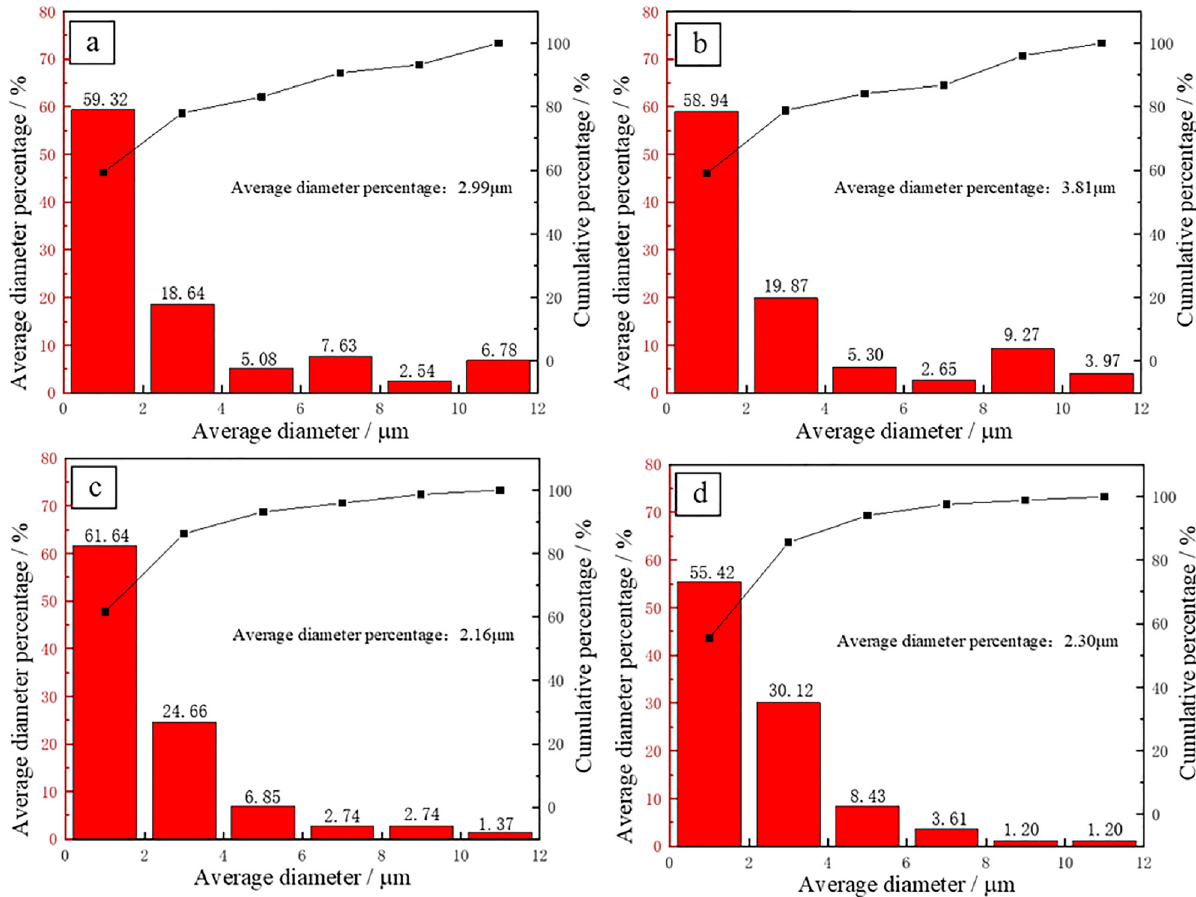
Figure 7: Distribution of inclusions in the metallographic structure of the CuW composites prepared with di ff erent R ( C/A ) ( a: 0, b: 0.2, c: 0.6, and d: 1.0 ) .